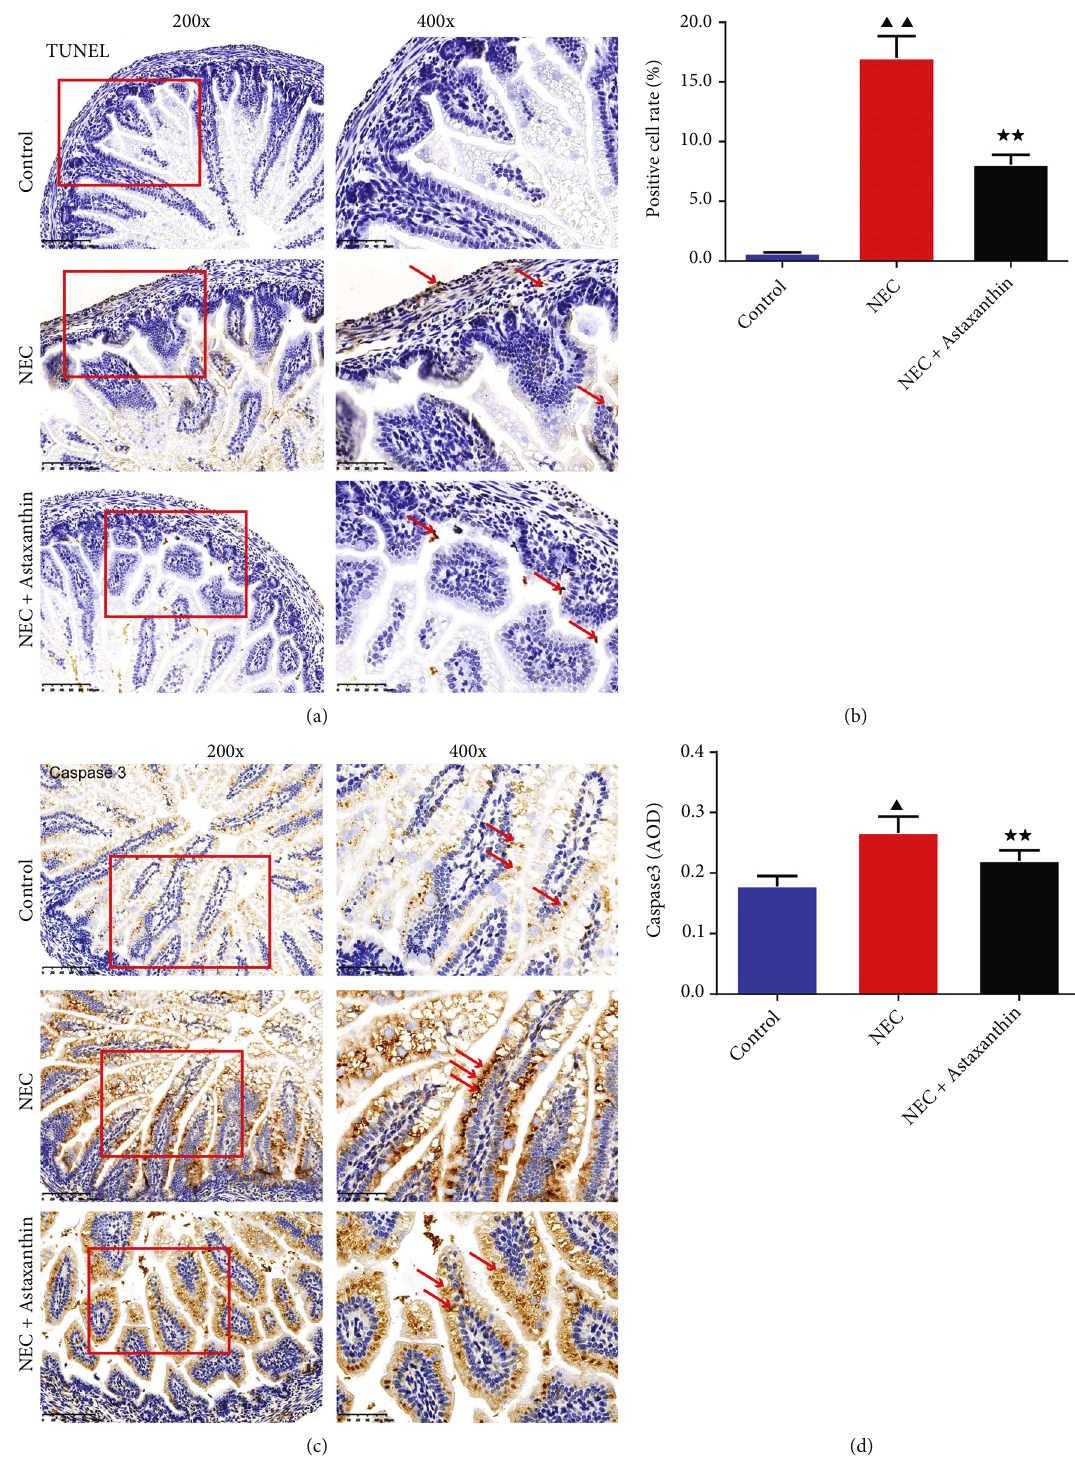
Figure 2: Astaxanthin protected the cells from apoptosis of intestinal tissues in NEC rats. (a and b) The apoptotic cells of intestinal tissues in rats are stained by the TUNEL kits, and the positive cell rates were calculated in each group (magni fi cation × 200, 400), n = 6 in each group. (c and d) The positive expression of Caspase 3 of intestinal tissues in rats was examined by immunohistochemistry (magni fi cation × 200, 400), and the average optical density (AOD) of the Caspase 3 was calculated in each group, n = 6 in each group. ▲ P < 0 : 05 , ▲▲ P < 0 : 01 vs. control group. ★★ P < 0 : 01 vs. NEC